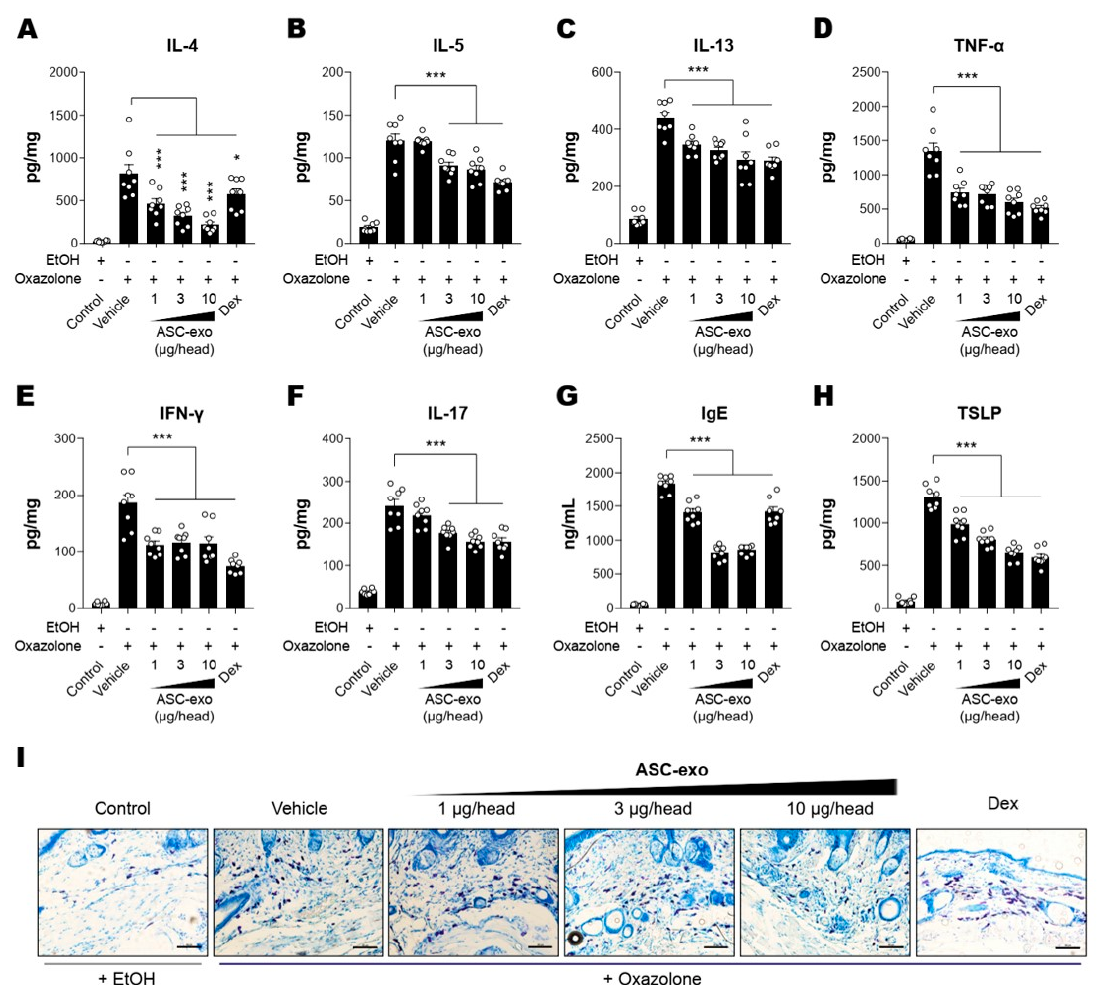
Figure 4. ASC-Exosomes reduce the level of multiple inflammatory cytokines in AD-like skin lesion of SKH-1 mice. The concentrations of ( A ) IL-4, ( B ) IL-5, ( C ) IL-13, ( D ) TNF- α , ( E ) IFN- γ , ( F ) IL-17, ( G ) IgE, and ( H ) TSLP in serum or lesional skin tissues were detected by ELISA. ( I ) Toluidine blue staining of the dorsal skin sections showing infiltration of mast cells into the AD-like skin lesions. Error bars depict the SEM. n = 8. *: p < 0.05, **: p < 0.01, ***: p < 0.001 vs. vehicle. Dex: dexamethasone. 3.5. ASC-Exosome-Mediated Improvements in Epidermal Barrier Functions Might be Attributed to